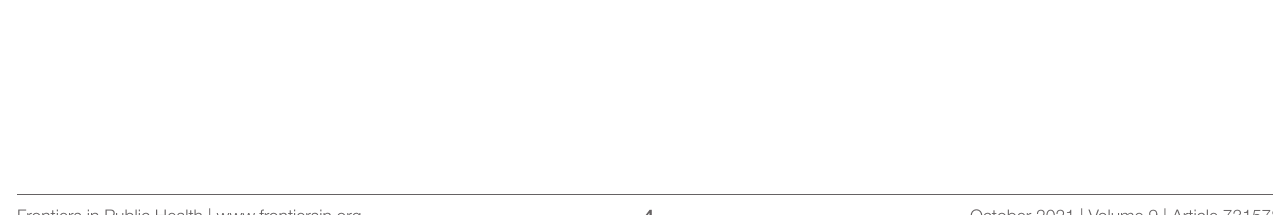
Frontiers in Public Health | www.frontiersin.org